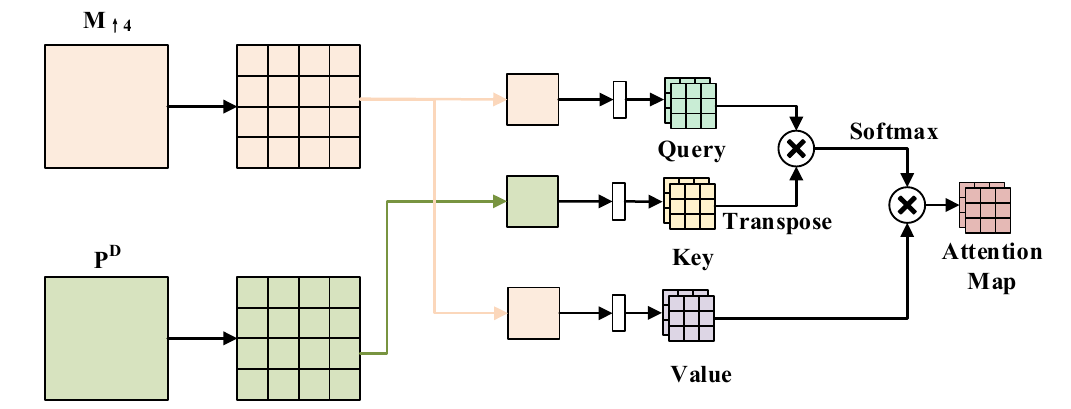
Figure 5. The structure of the SPTM.